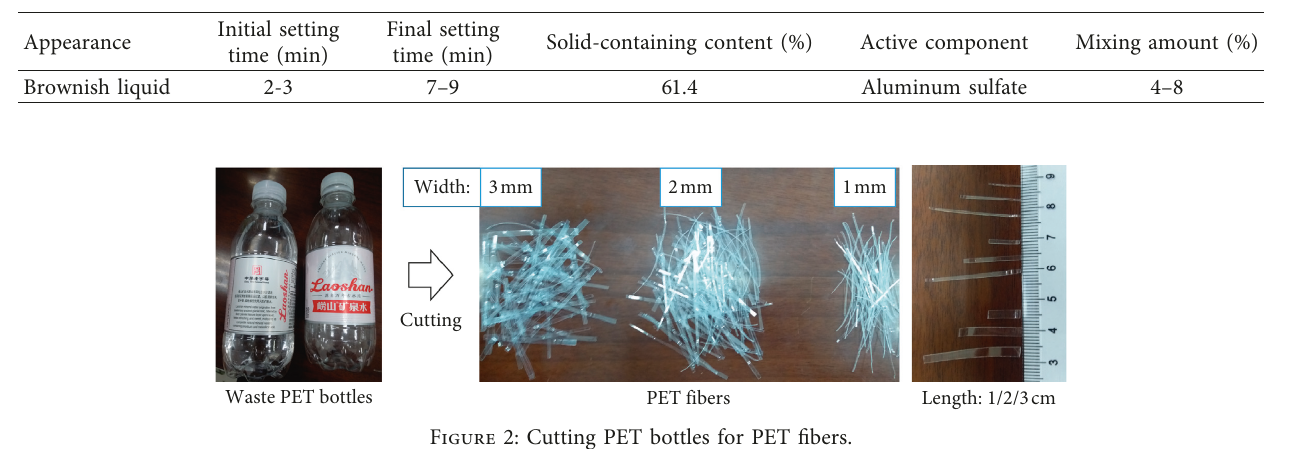
Table 1: Physical properties of the WT-N1-type nonalkali liquid